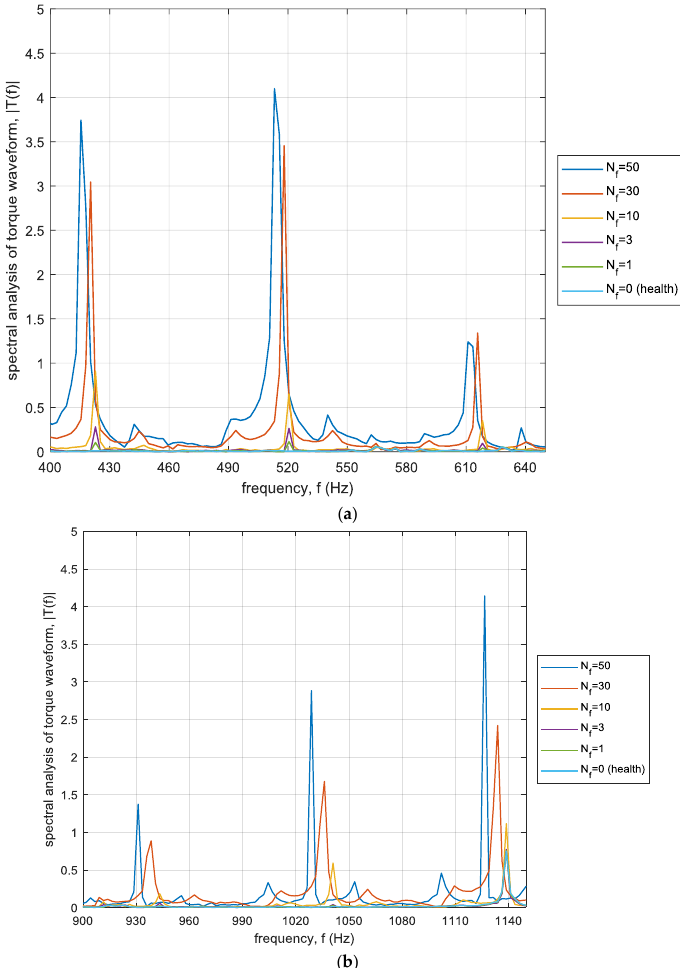
Figure 14. Spectral analysis of the torque waveform of a faulty motor limited in frequency: ( a ) Figure14. Spectralanalysisofthetorquewaveformofafaultymotorlimitedinfrequency: ( a )400–650Hz 400–650 Hz and ( b ) 900–1150 Hz, at T L = 15 Nm. and ( b ) 900–1150 Hz, at T L = 15